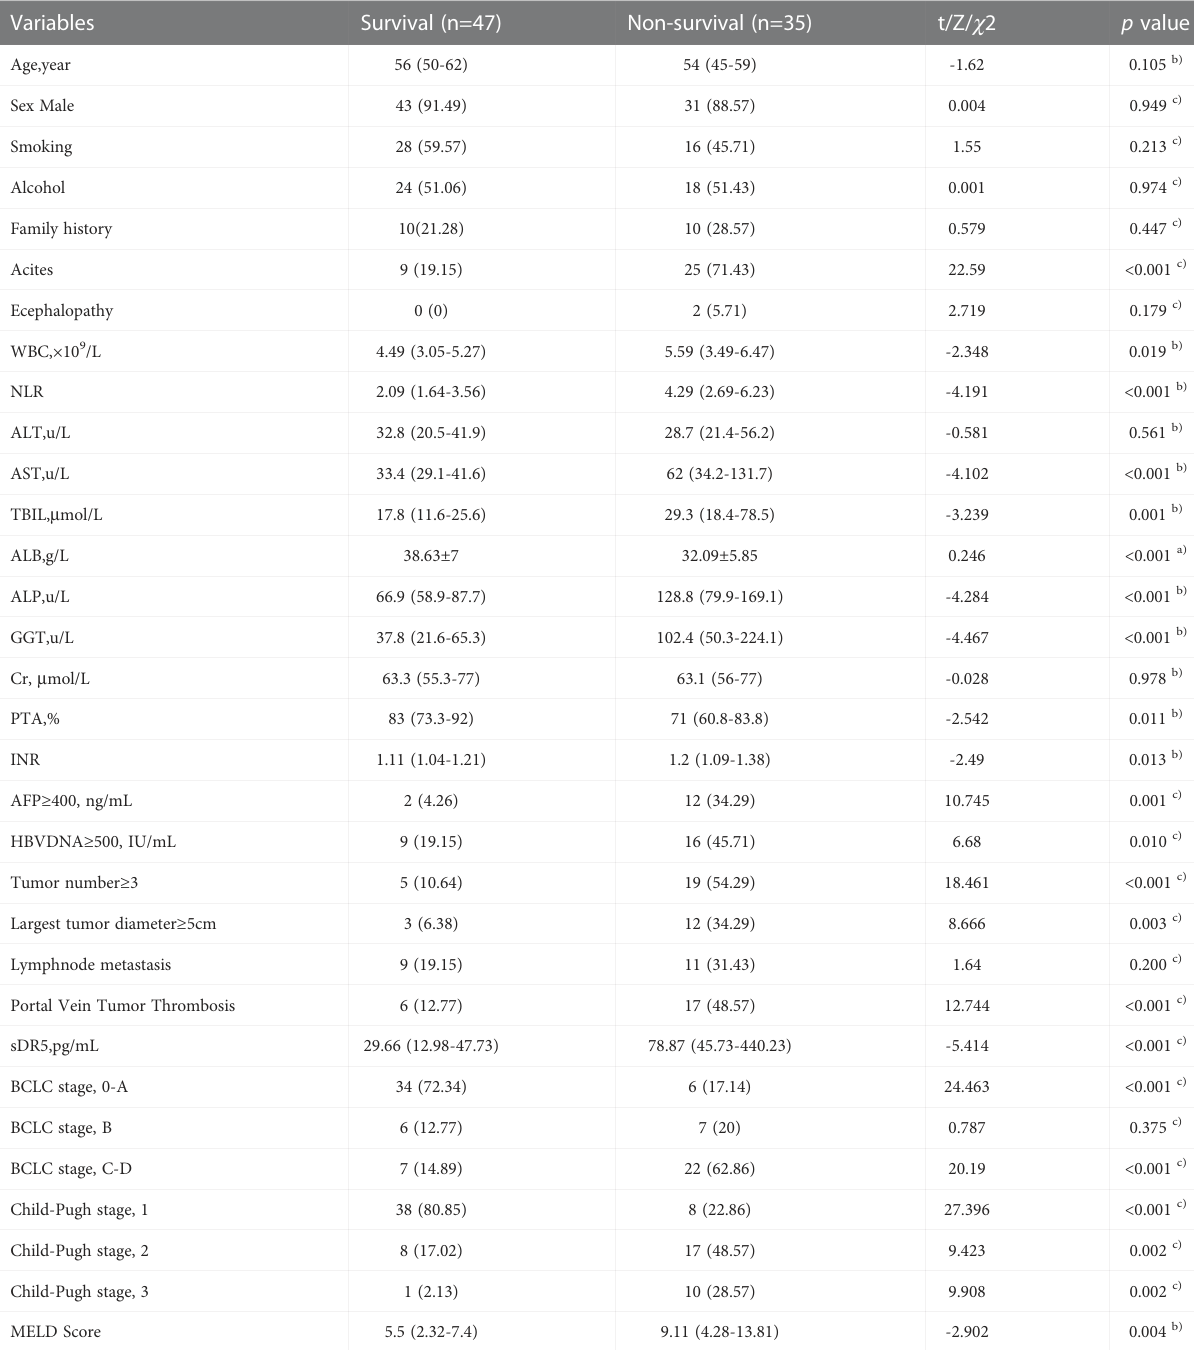
TABLE 2 Clinical characteristics of patients with HBV-related hepatocellular